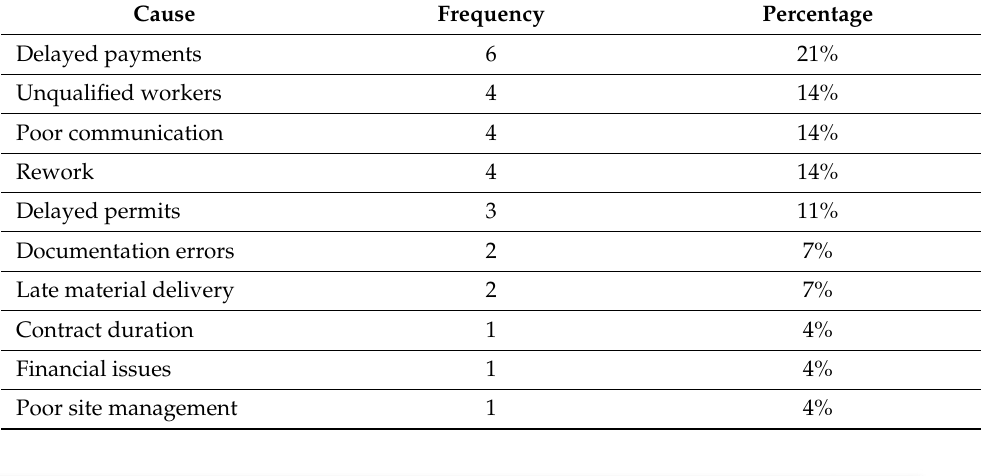
Table 4. Frequency and percentage of occurrence of each cause.